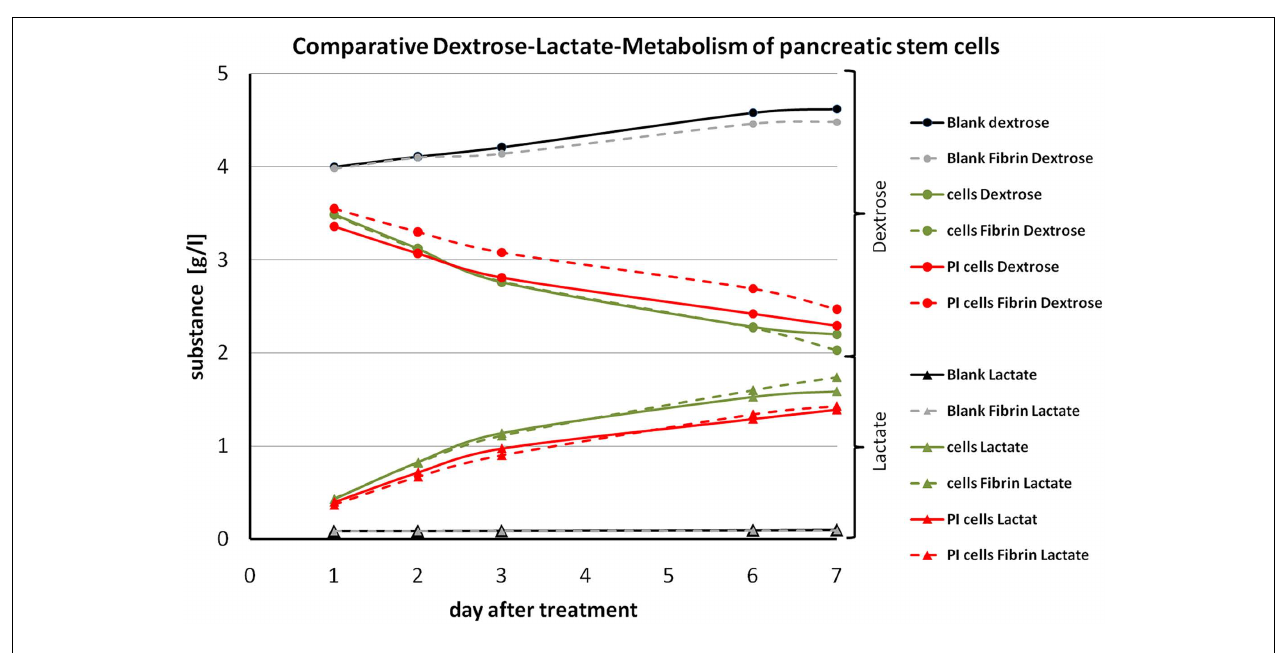
and solid lines for non-coated samples. Gray and black lines represent the blanks. Green lines are used for samples on cell culture plastic and red lines for samples on polyimide films. Sample names are depicted in the